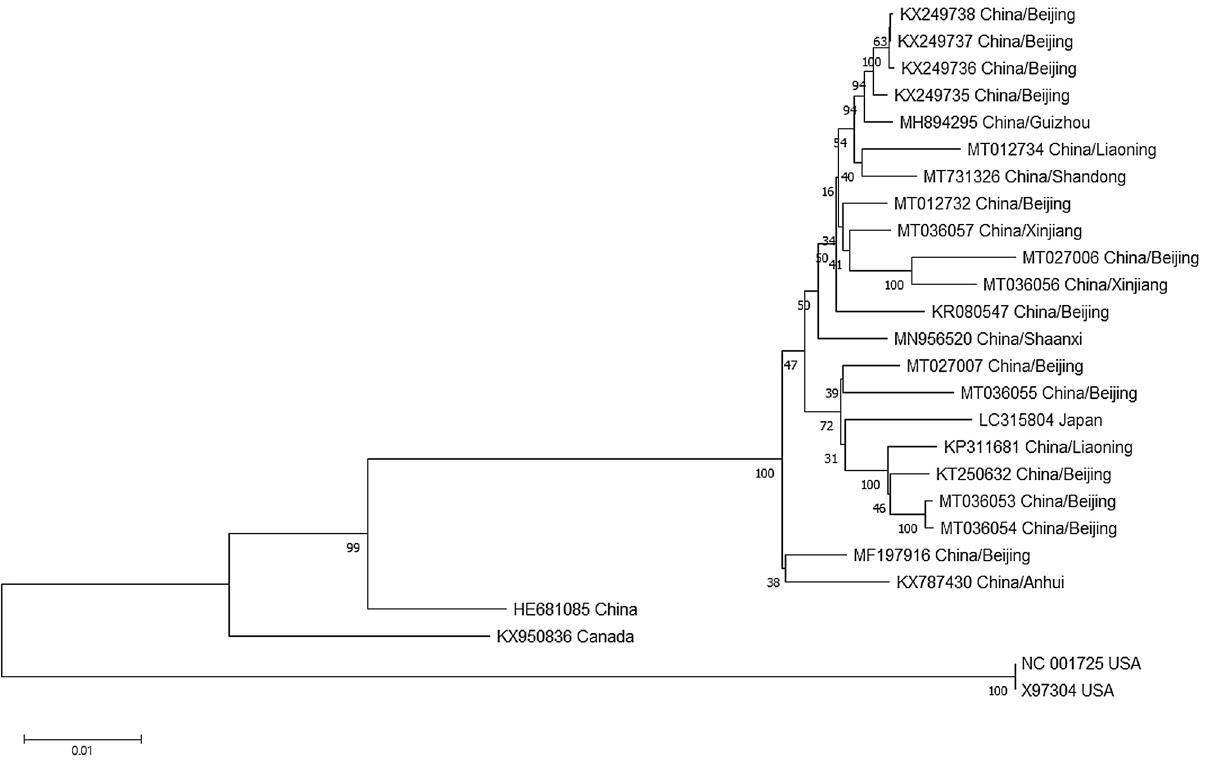
Figure 2. Phylogenetic relationship of the complete genomic sequences of SVBV isolates. All complete genomic sequences of SVBV isolates currently available were used to construct the NJ phylogenetic tree with 1000 bootstrap value by the software of MEGA